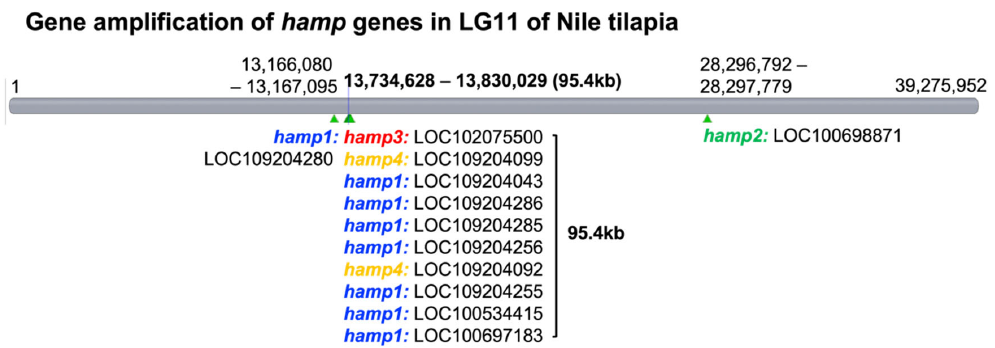
Figure 2. The gene amplification of hepcidin hamp genes in LG11 of Nile tilapia. There are 12 hamp genes including 8 hamp1 , 1 hamp2 , 1 hamp3, and 2 hamp4 genes distributed into three locations indicated by green arrow heads in the LG11 of Nile tilapia.